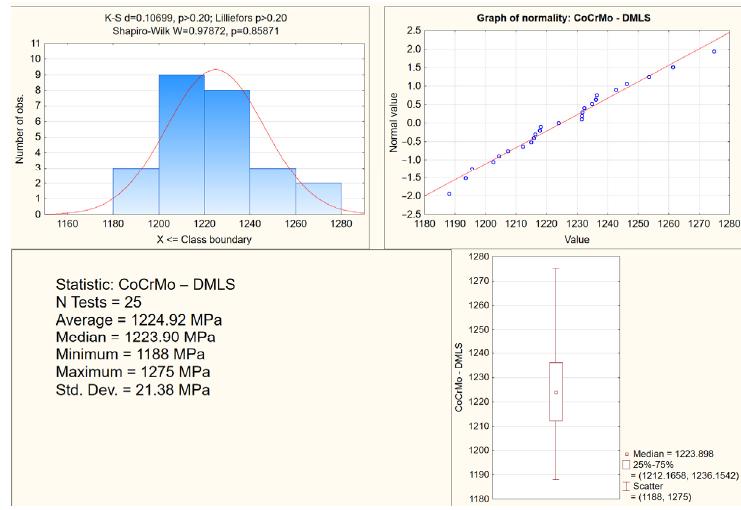
Figure 5. An exemplary analysis of the distribution normality of the offset yield strength in tensile tests for CoCrMo from DMLS.